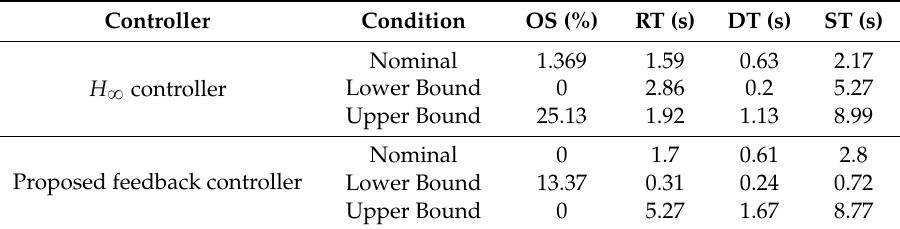
Figure 7. Step response for the HEV speed control ( a ) with the 𝐻 ∞ controller and ( b ) with the robust feedback controller. Table 3. The comparison of the time domain performance index: overshoot (OS), rise time (RT), delay time (DT) and settling time (ST).